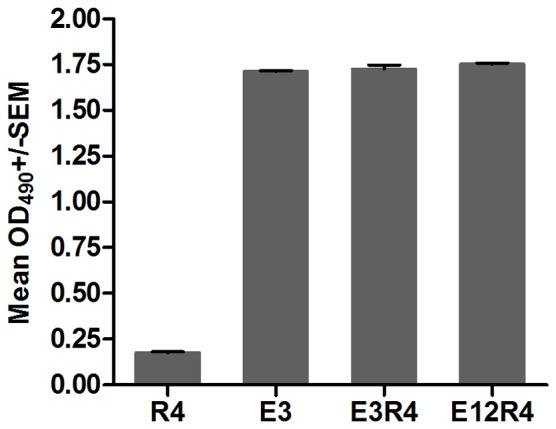
Reactivity of RG-1 with L2R4 proteins.ELISA plates were coated with 100(E3R4, E12R4, R4), or 5 ng of E3 peptide (equivalent to the amount of R4 based proteins on a mole basis). Binding of a 1∶3,000 dilution of RG-1 was detected with HRP-conjugated goat-anti-mouse IgG. Reactivity was determined by measuring the mean optical density (OD) values at 490 nm. Error bars indicate standard error of the mean (SEM) of triplicate wells. Results are expressed as mean±SD. The experiment was repeated twice.